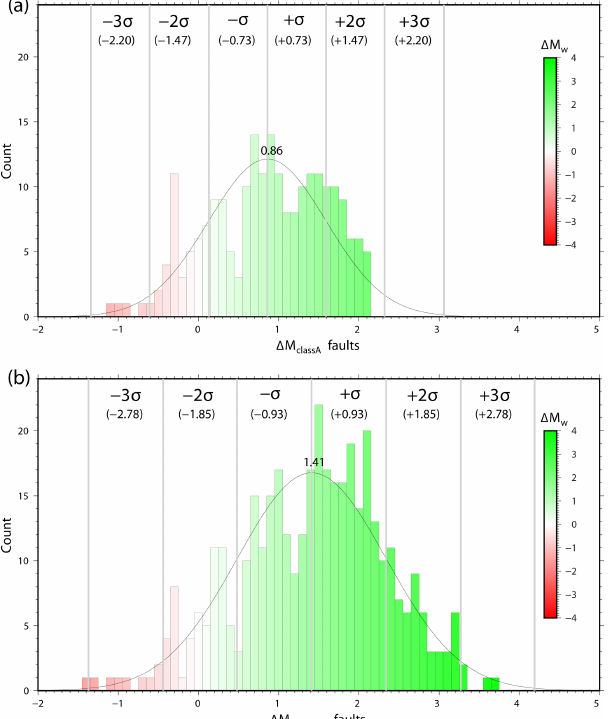
Figure 12. (a) Histogram of the difference between FLEMs (from class A faults) and spatially coincident (same cell) his- torically/instrumentally catalogued magnitudes of earthquakes. Mean = 0.86; deviation standard σ = 0.73. (b) Histogram of the dif- ference between FLEMs (from class A and B faults) and spatially coincident (same cell) historically/instrumentally catalogued mag- nitudes of earthquakes. Mean = 1.41; deviation standard σ = 0.93. In both histograms, values in the negative fields can be interpreted as FLEM’s underestimation with respect to catalogued earthquake magnitudes, whereas values in the positive fields could be inter- preted either as FLEM’s overestimation with respect to catalogued magnitudes or as a sort of catalogue incompleteness. Occurrences in the positive fields (green portions) are significantly more frequent than occurrences in the negative fields (red portions). Green and red colours in Figs. 10, 11, and 13c have the same meaning as in this figure. See text for further information.